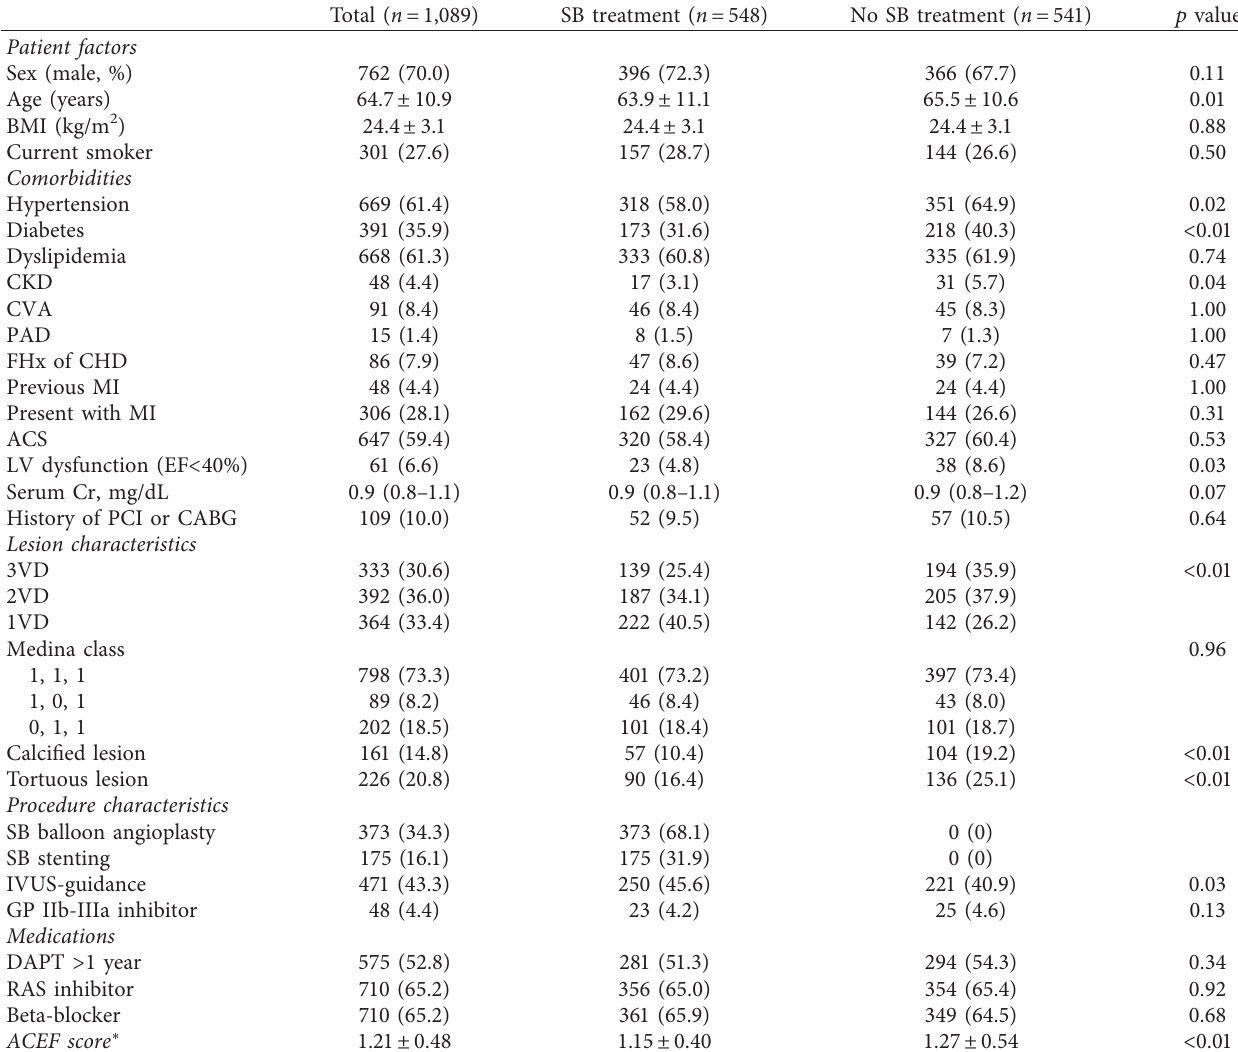
Table 1: Baseline characteristics according to SB treatment.